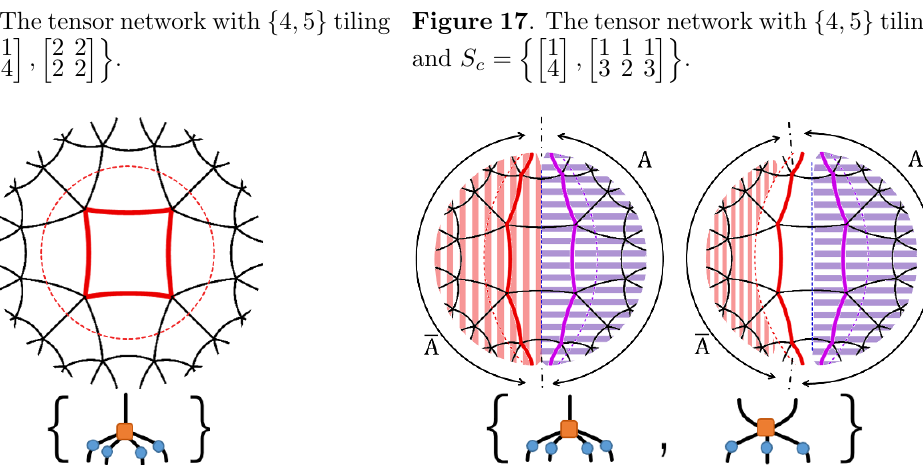
Figure 19 . The tensor network with f 4 ; 5 g tiling and S c =